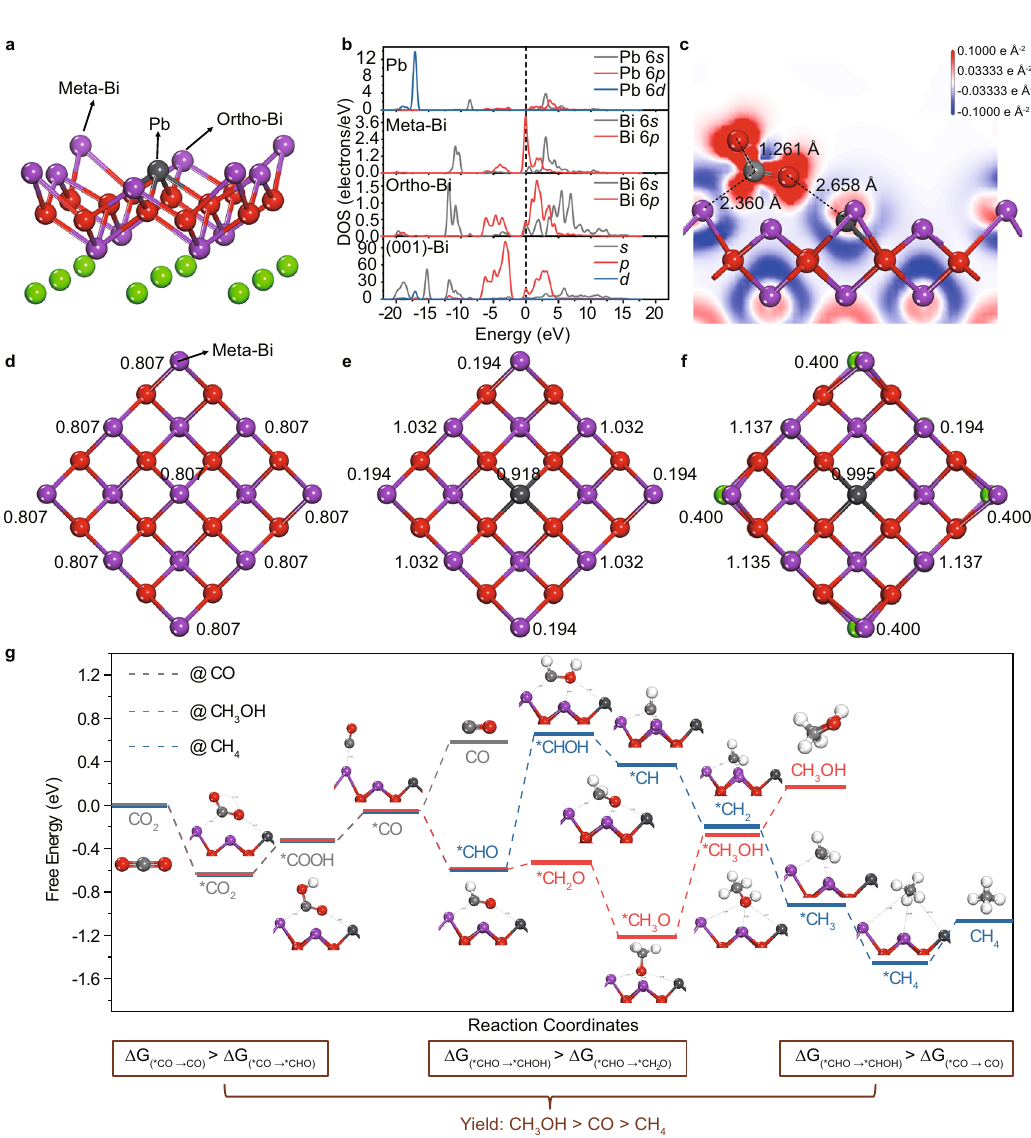
Fig. 5 Electronic structure and CO 2 RR pathways of ultrathin PBOC layers. a Lead – bismuth oxyhalide outer layer structural model and ( b ) the partial density of states (PDOS). c Isosurface of differential charge density. Mulliken population of ( d ) layer bismuth oxyhalide layer, e lead – bismuth oxyhalide outer layer and ( f ) lead – bismuth oxyhalide outer layer after CO 2 adsorption. g Gibbs free energy calculations towards the reaction pathway and free energy diagrams. The grey, red and blue lines show the reaction pathway of CO 2 RR to CO, CH 3 OH, and CH 4,